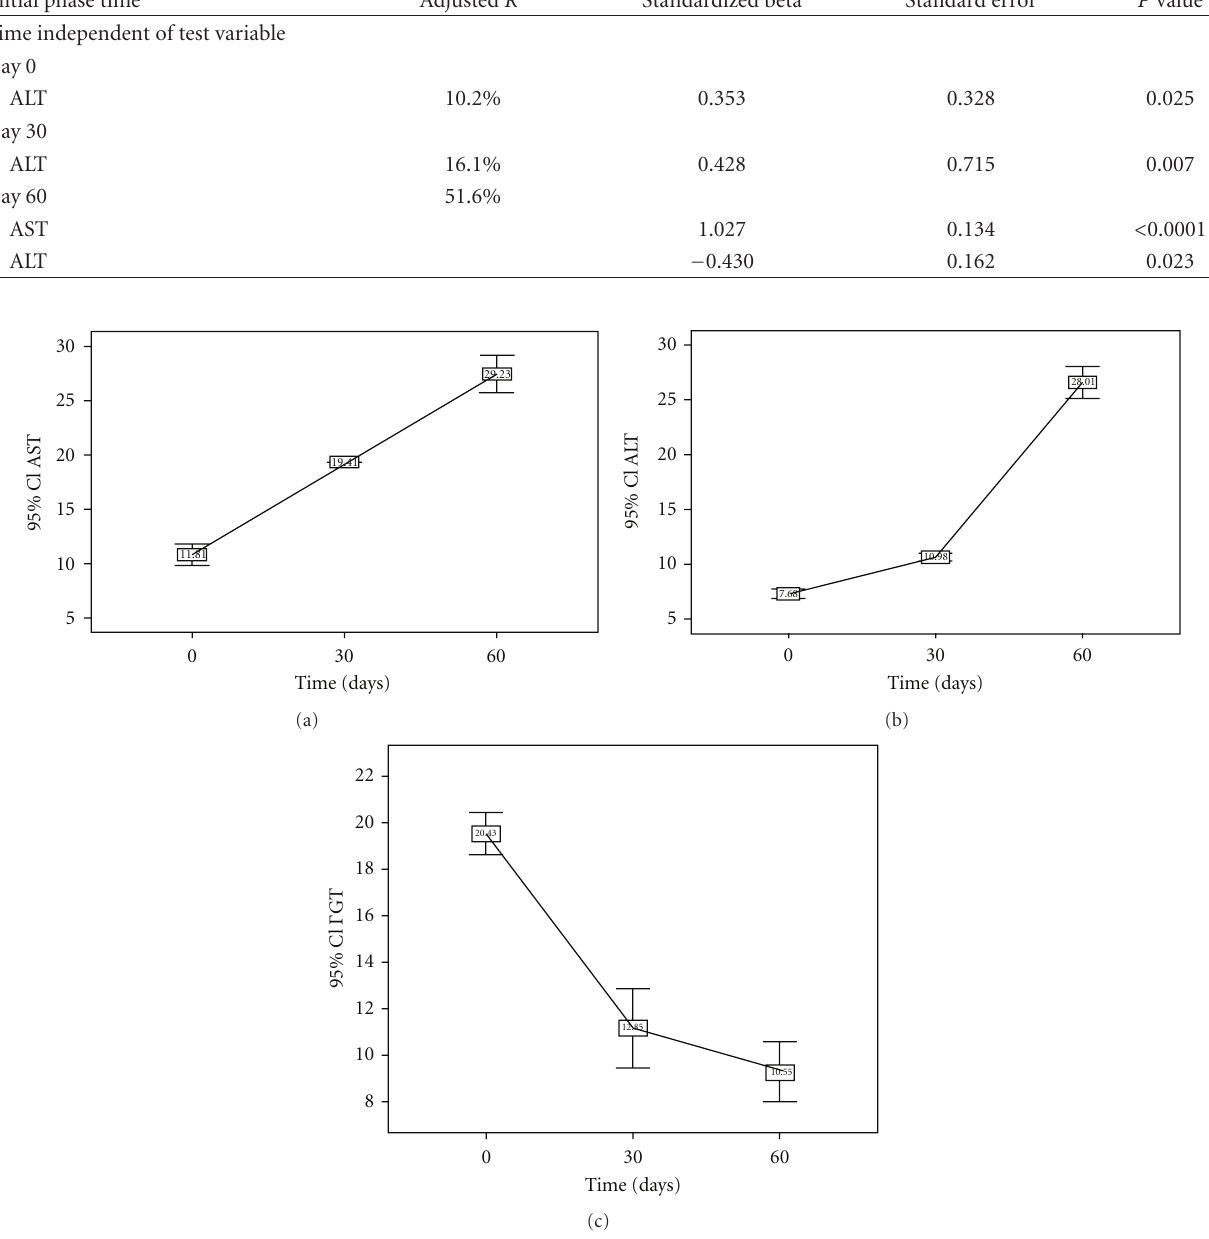
Figure 1: Variations of AST, ALT, and GGT during the two months of initial phase with their Bonferroni post hoc tests. ∗ Day 0 versus day 30: P < 0 . 0001; day 0 versus day 60: P < 0 . 0001. ∗ Day 30 versus day 60: P < 0 .